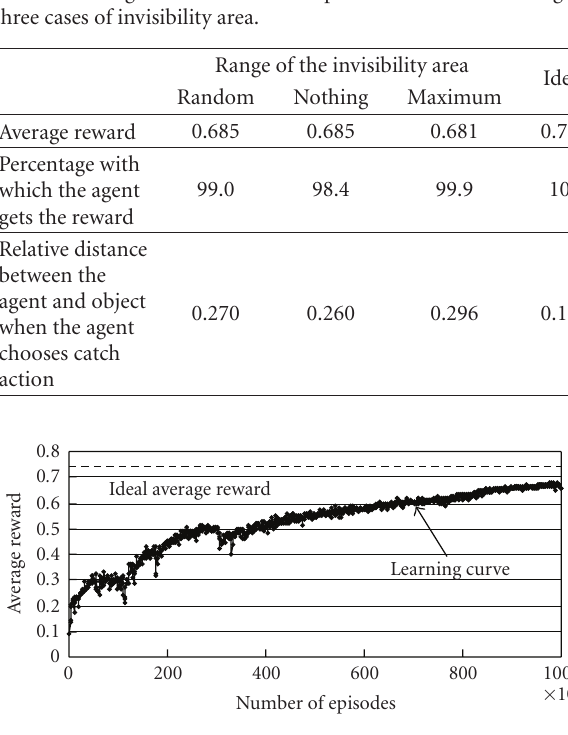
Figure 3: Learning curve. Change in the average reward according to the number of episodes is shown. Broken line shows the ideal average reward under the assumption that the agent always catches the object at the optimal timing and